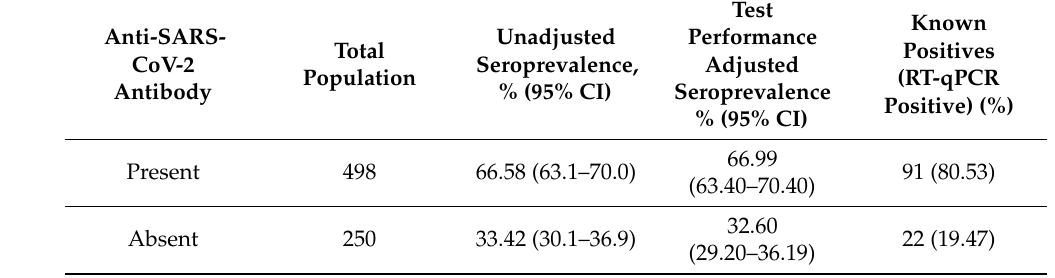
Table 1. Prevalence estimation in CMA.